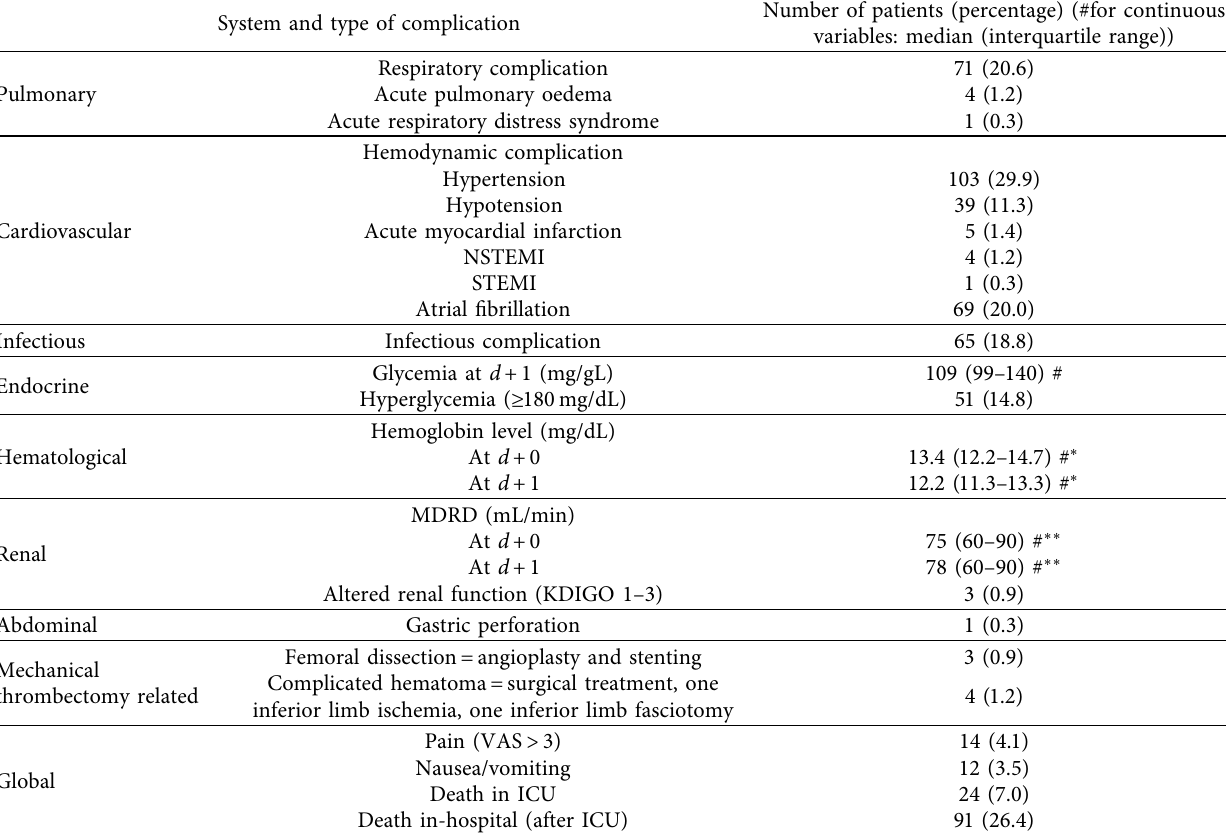
Table 3: Non-neurological ICU complications.